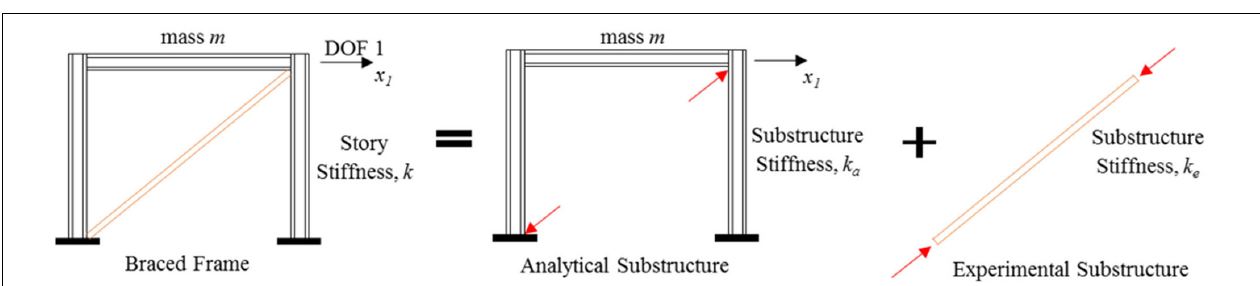
FIGURE 2 | Model and substructuring of diagonal CBF for HS